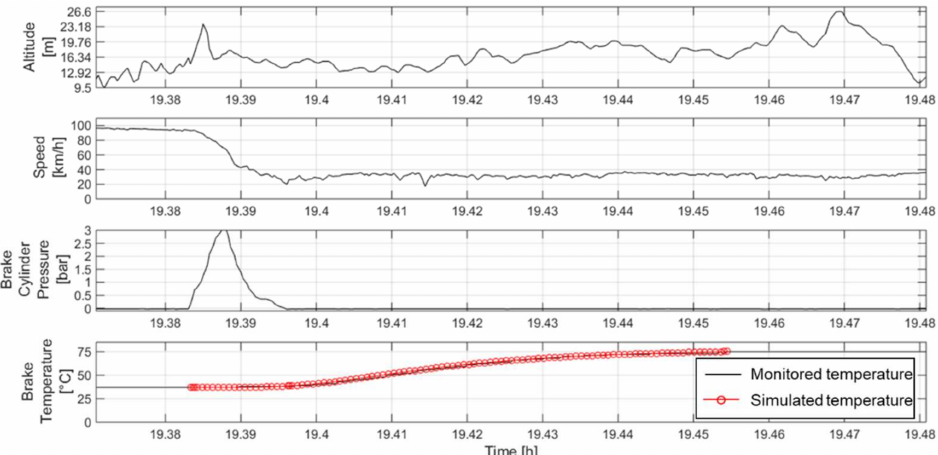
Figure 9. Braking maneuver B—comparison of measured and simulated temperature of the brake block at the position where the sensor is